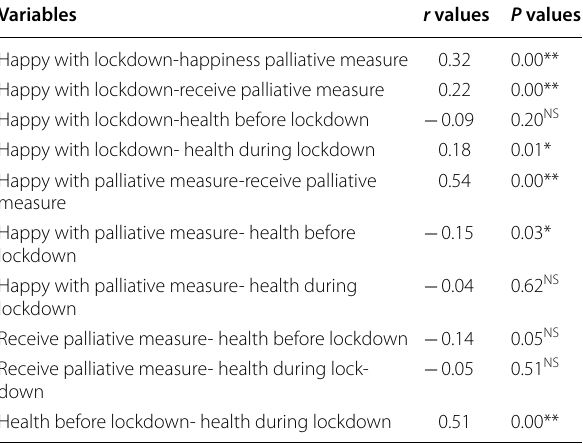
and during COVID-19 lockdown